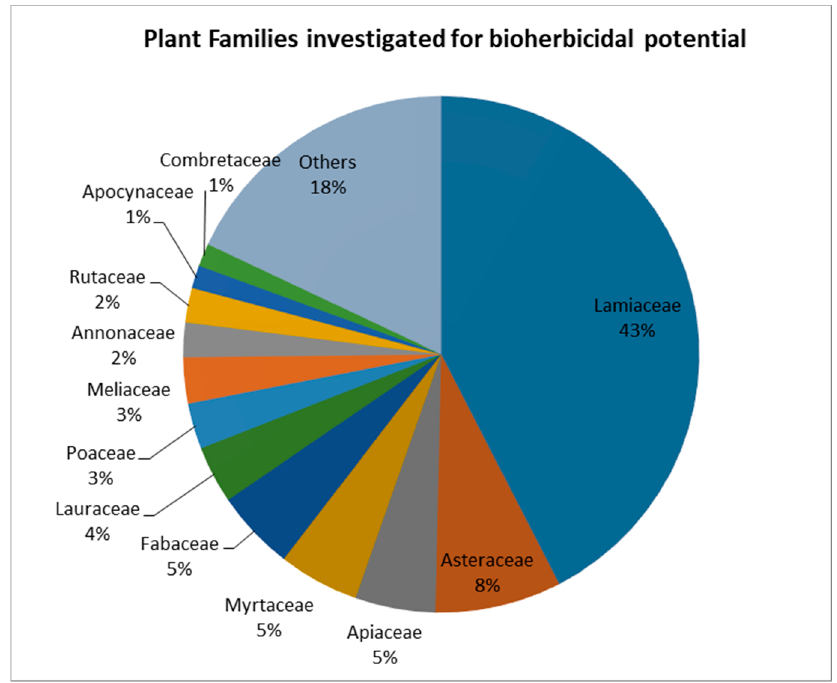
Figure 1. Plant families studied for their bioherbicidal potential. (Source: elaborated from a search on Scopus,